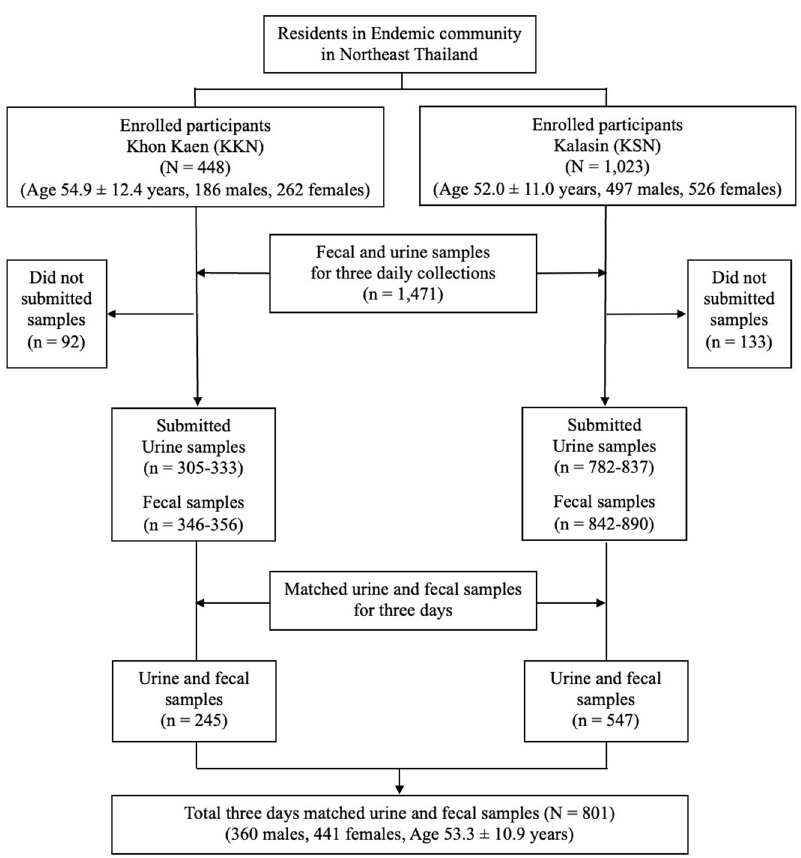
Fig 1. Flow diagram for recruitment of study participants to examine the daily fluctuation of fecal egg counts and antigen levels in urine in opisthorchiasis. The participants were residents from Muang District, Khon Kaen Province (KKN) and Nong Kung Sri District, Kalasin Province (KSN), Northeast